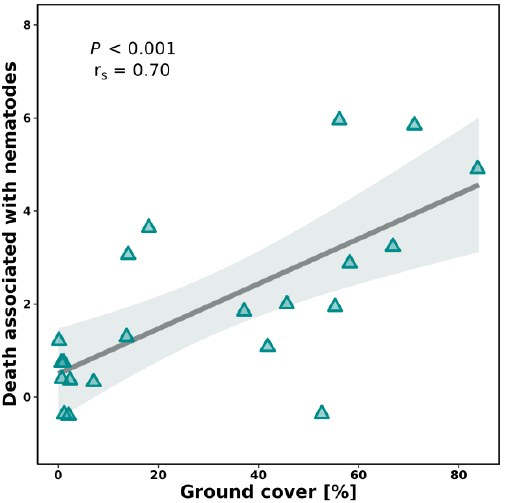
Figure 3. Spearman correlation between ground cover and the number of dead slugs with the presence of killed by nematodes.